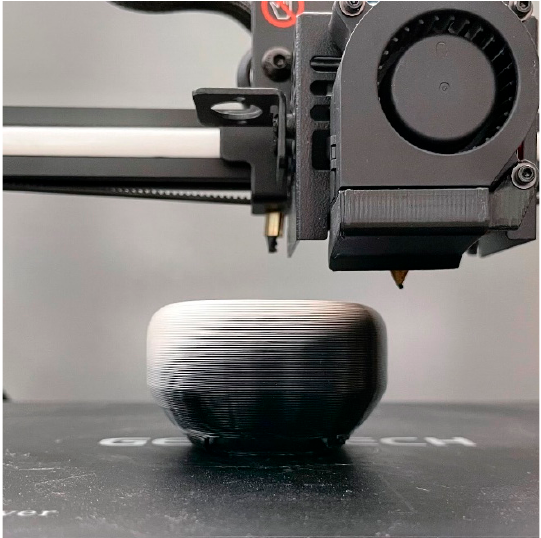
Figure 9. Manufactured part using functionally graded material.